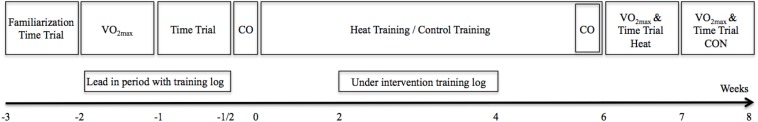
Study overview and time course. CO, carbon monoxide rebreathing procedure.